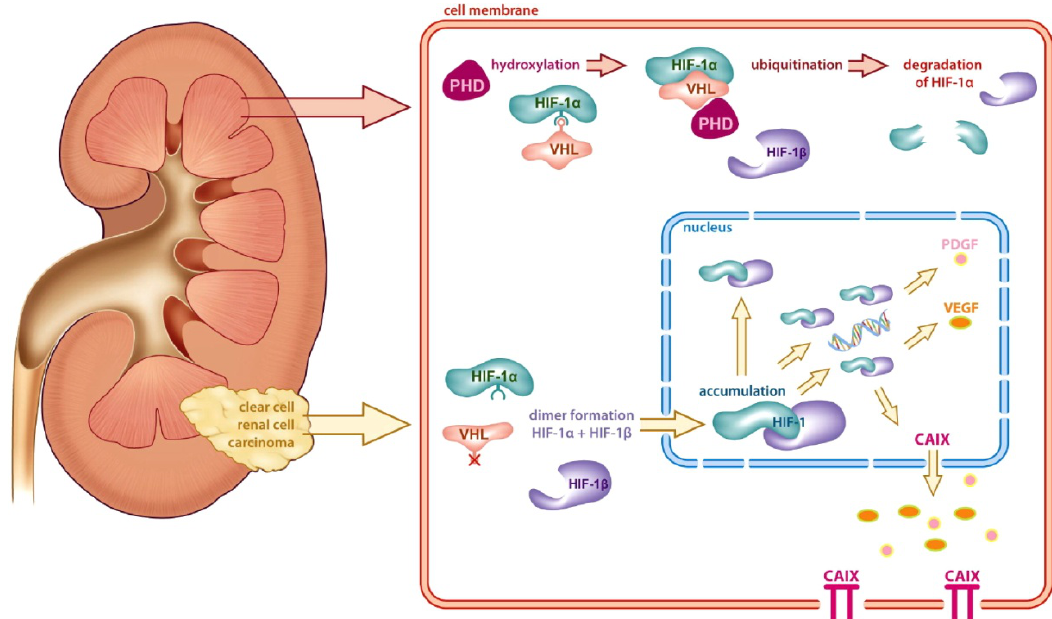
Figure 1. Schematic representation of regulation of carbonic anhydrase IX expression (CAIX) in kidney. In normal kidney tissue, hypoxia inducible factor-1 α (HIF-1 α ) is hydroxylated by prolyl hydroxylase domain proteins (PHD) and bound by Von Hippel-Lindau protein (pVHL). Subsequently, the complex is ubiquitinated, which causes degradation of HIF-1 α . In clear cell renal cell carcinoma (ccRCC), pVHL is mutated and binding with HIF-1 α is prohibited. Subsequently HIF-1 α forms a heterodimeric complex with HIF-1 β , translocates to the nucleus, where it activates hypoxia inducible genes, such as vascular endothelial growth factor and CAIX, which is expressed on the tumor cell membrane. Reproduced with permission from Stillebroer et al ., European Urology, published by Elsevier, July, 2010; 58(1): 75–83